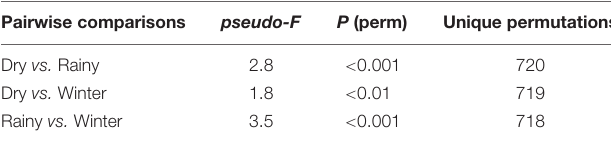
TABLE 3 | Multivariate pairwise comparisons amongst centroids calculated based on hemocyte concentration and biochemical descriptors measured in the tissues (hemolymph, hepatopancreas, gonads, and muscle) of Octopus maya collected in three seasons (winter, dry, and rainy season). Pairwise comparisons pseudo-F P (perm) Unique